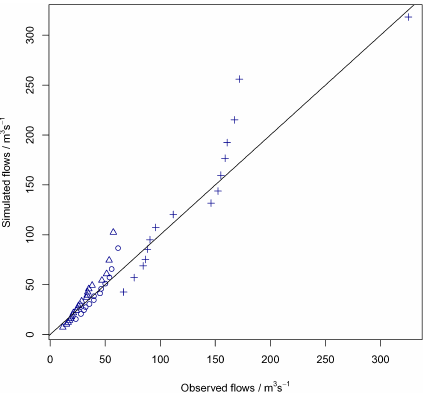
Fig. 12. Quantile plots for the distributions of annual maximum flows: B1Z1 ( ◦ ), B2Z1 (+), B1Z2 ( 4 ). (The values plotted have equal